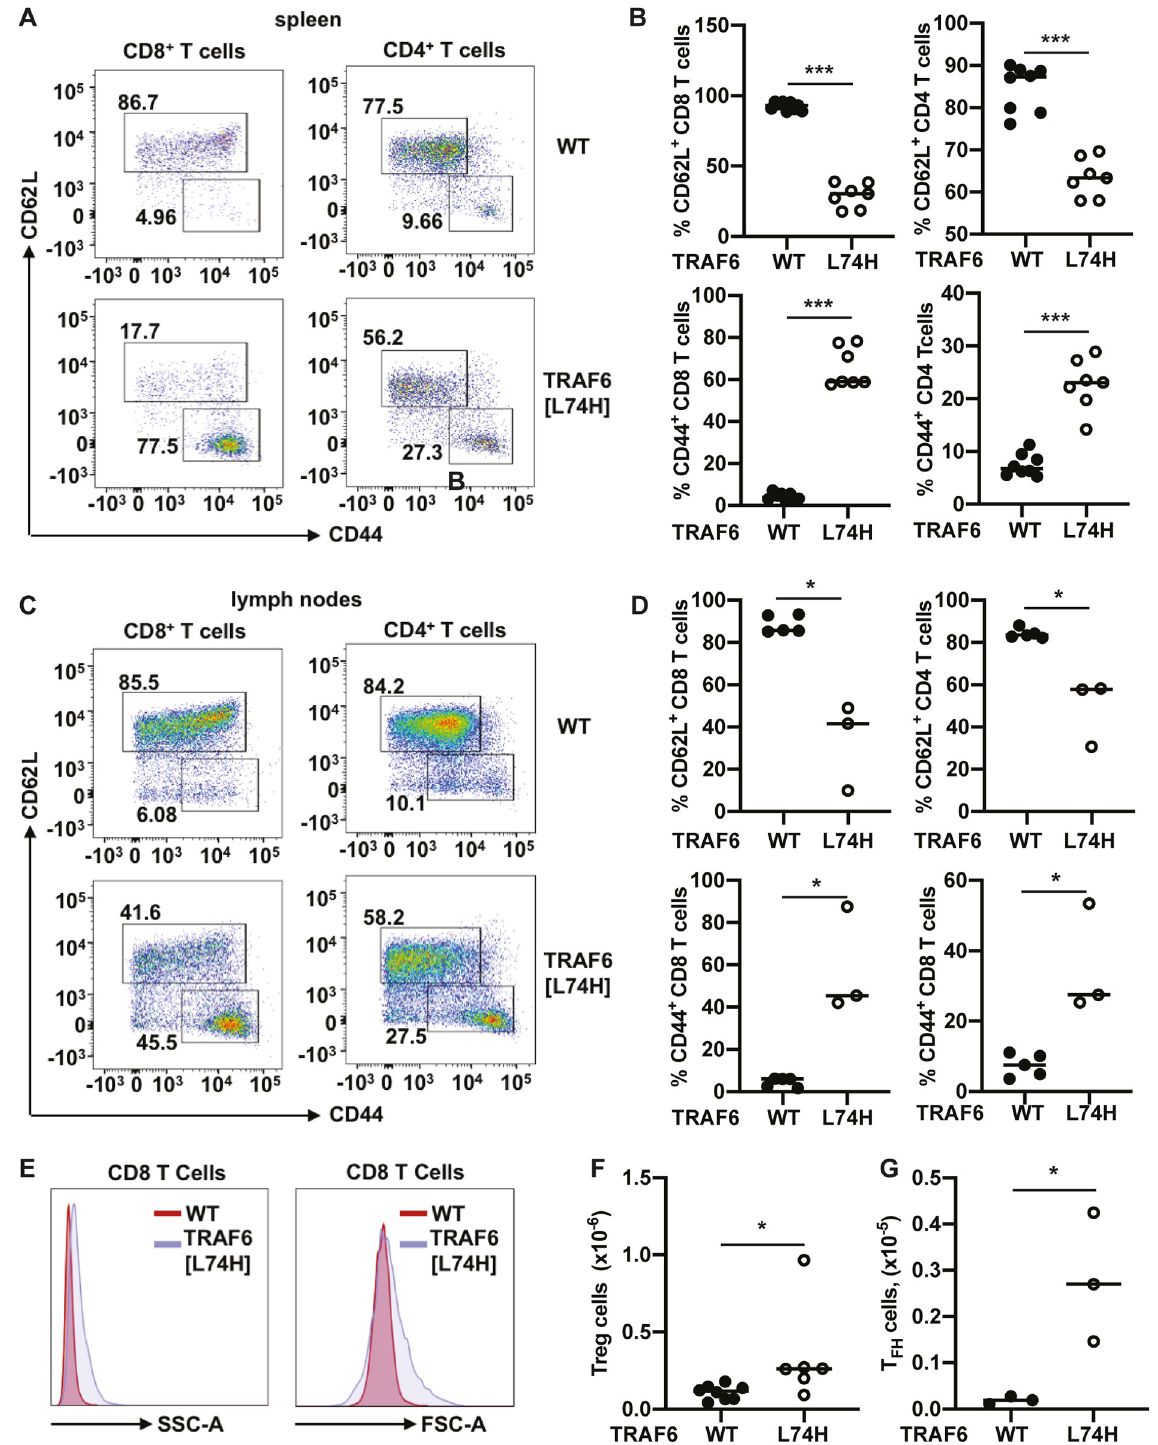
Fig 7. The T cells from TRAF6[L74H] knock-in mice display activated phenotype. (A) Representative flow cytometry plots showing expression of CD62L and CD44 within the CD8 (DAPI - TCR β + CD8 + population) and CD4 (DAPI - TCR β + CD4 + population) T cells in the spleens of WT (n = 8) and TRAF6[L74H] (n = 7). (B) Graphs showing percentages of CD62L + CD8 T cells (top left-hand panel), CD62L + CD4 T cells (top right-hand panel), CD44 + CD8 T cells (bottom left-hand panel) and CD44 + CD8 T cells (bottom right-hand panel). (C, D) As in A and B, except plots show data from lymph nodes of 5 WT and 3 TRAF6[L74H] mice. (E) Representative histograms showing side scatter-area